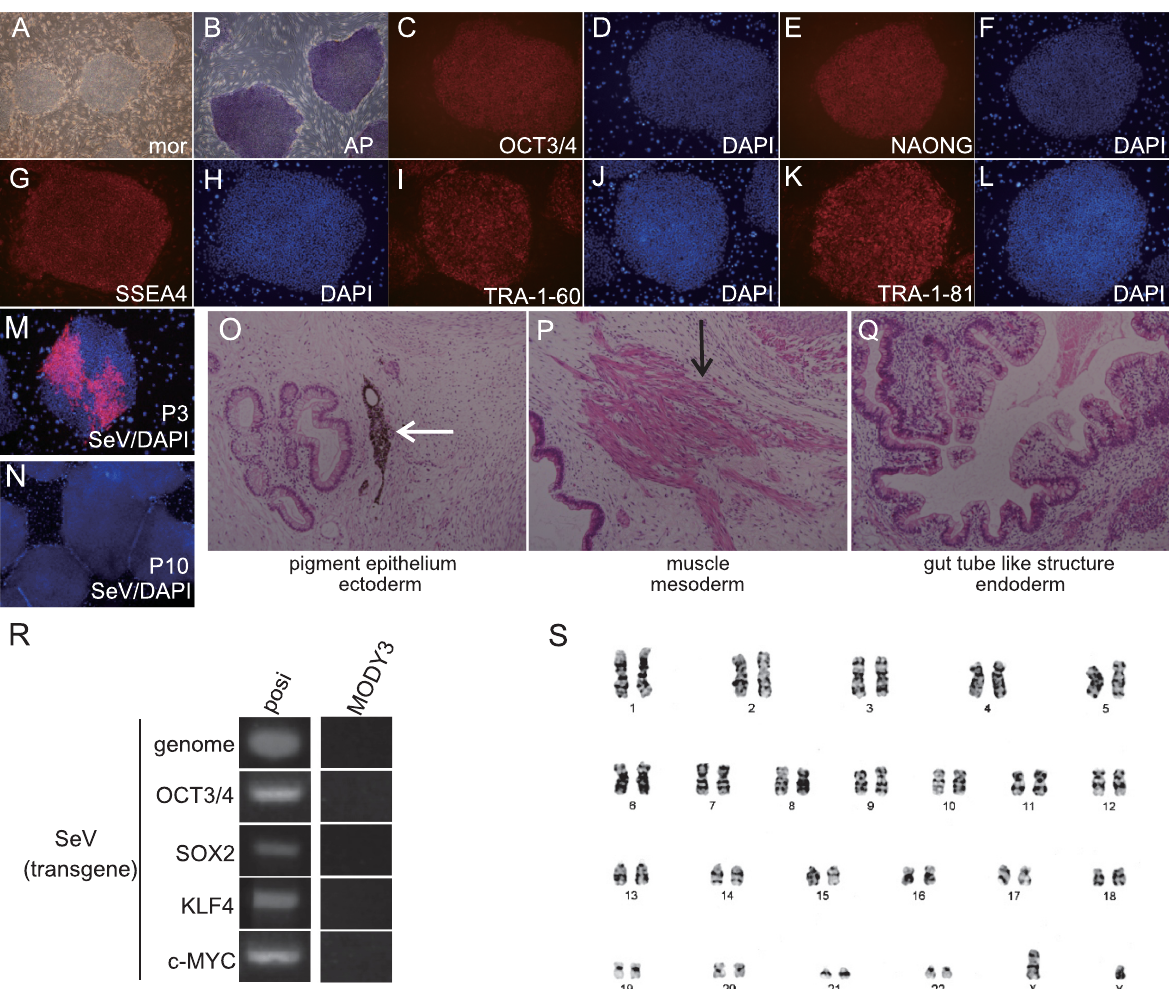
Fig 2. Characterization of pluripotency of MODY3-iPSCs. (A) Representative phase-contrast image of MODY3-iPSCs colonies. mor: morphology of iPSCs. (B) Positive image of alkaline phosphatase (AP) staining. (C-L) Immunocytochemistry for undifferentiated pluripotency markers. (C):OCT3/4, (E):NANOG, (G):SSEA4, (I): TRA-1-60, (K):TRA-1-81, (D,F,H,J,L):DAPI, (M, N) Immunocytochemistry for SeV. (M): passage 3, (N):passage 10 (O-Q): teratoma derived from MODY3-iPS cells (O):ectoderm; pigment epithelium, (P):mesoderm; muscle cells, (Q): endoderm; gut-tube-like structure. White arrow indicates pigment epithelium. Black arrow indicates muscle cells. (R) RT-PCR analysis of transgenes by SeV vector. Posi: positive control (SeV infected-fibroblast cells), MODY3: MODY3-iPSCs. (S):karyotype analysis by G-band method.